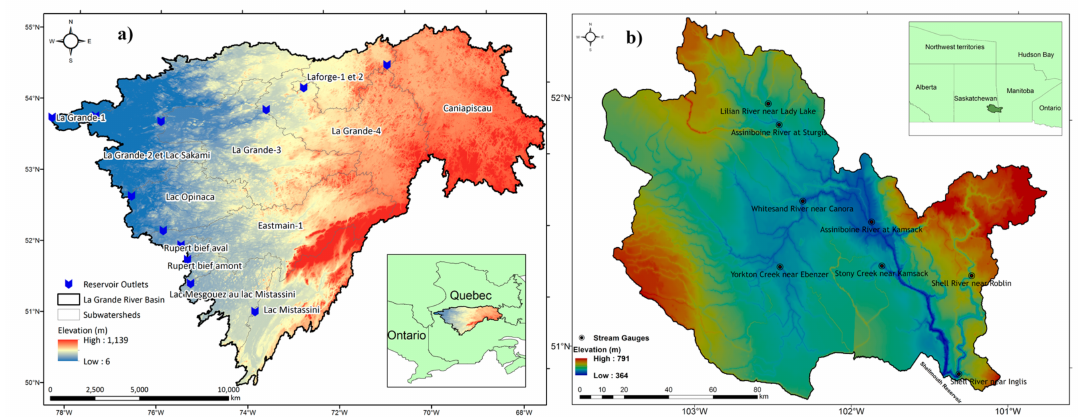
Figure 1. ( a ) La-Grande River Basin (LGRB), Quebec, Canada (Left) and ( b ) Upper Assiniboine River at Shellmouth Reservoir (UASR), Manitoba, Canada